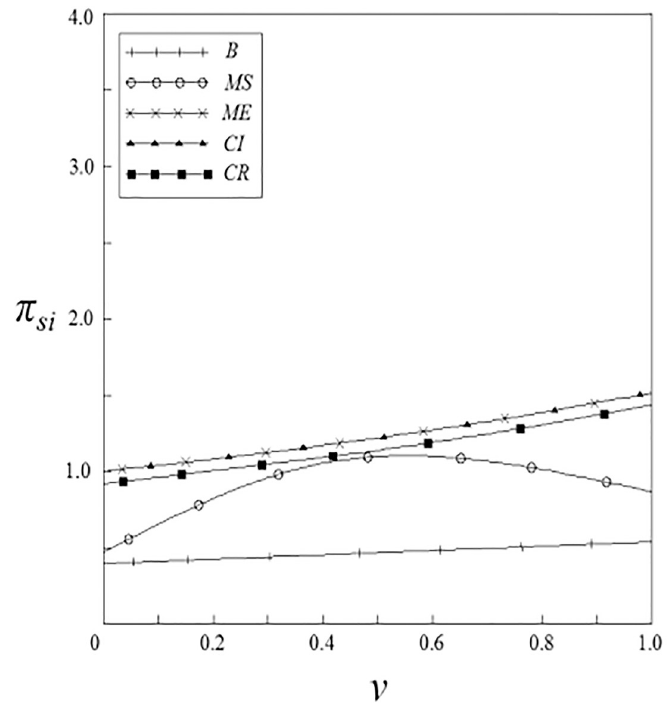
Fig 11. The relationship between π si and ν